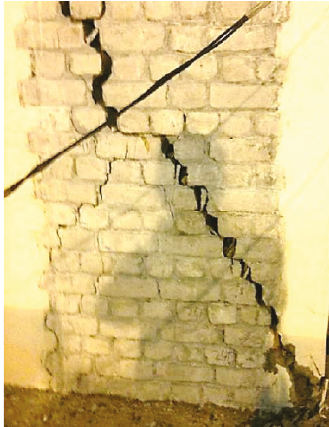
Figure7:Diagonalshearcracksinpier1correspondingtostorydrift of 0.34%.